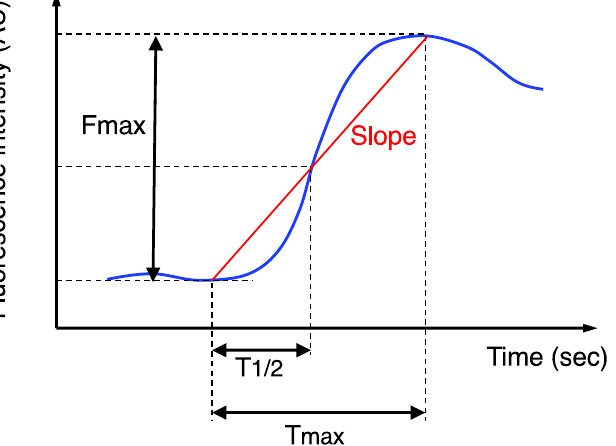
Figure 1. Time curve of the ICG fluorescence intensity. Fmax, Tmax, T1/2, and Slope were calcu-